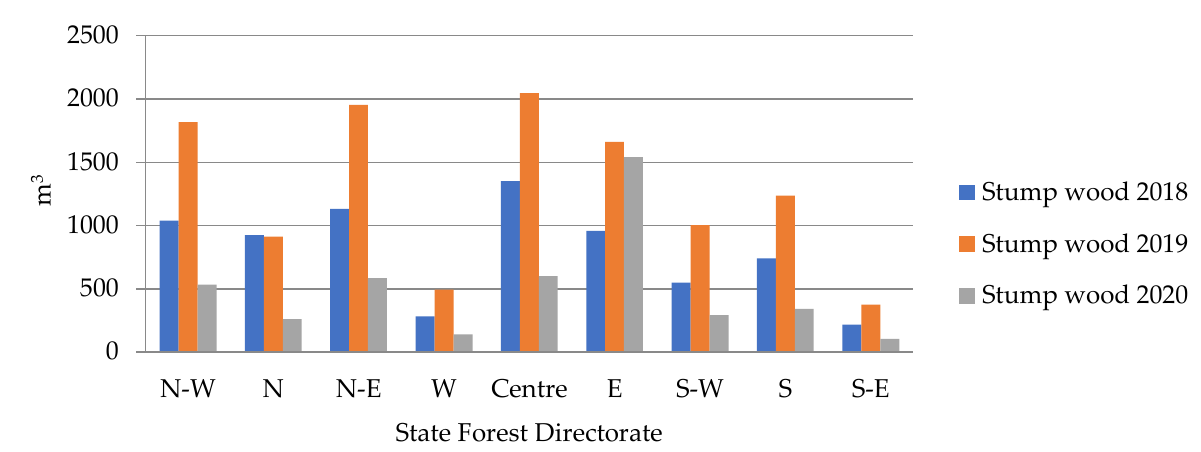
Figure 10. The amount of stump wood harvested in Poland between 2018 and 2020. Own elaboration based on the available data.